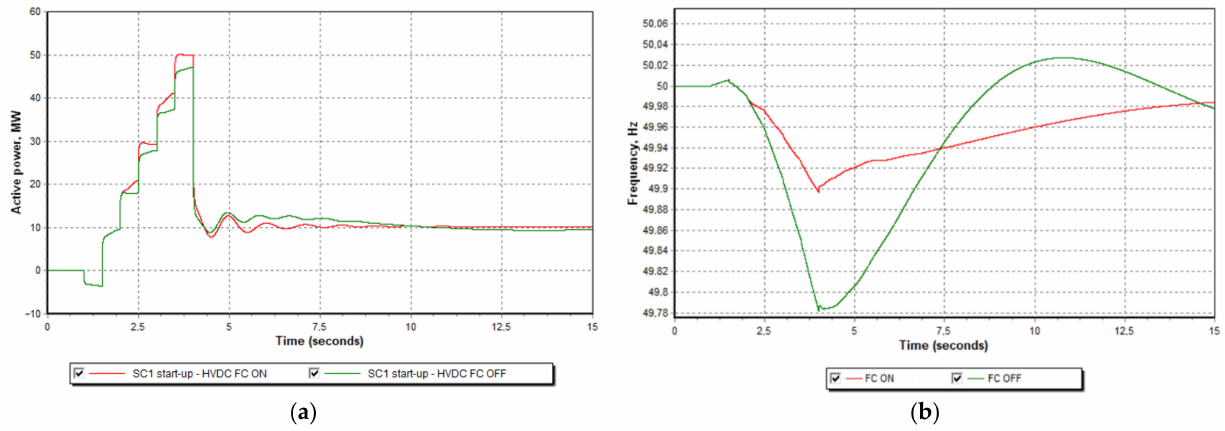
Figure 20. ( a ) Load of SC at start-up. ( b ) Frequency change in the isolated power system.